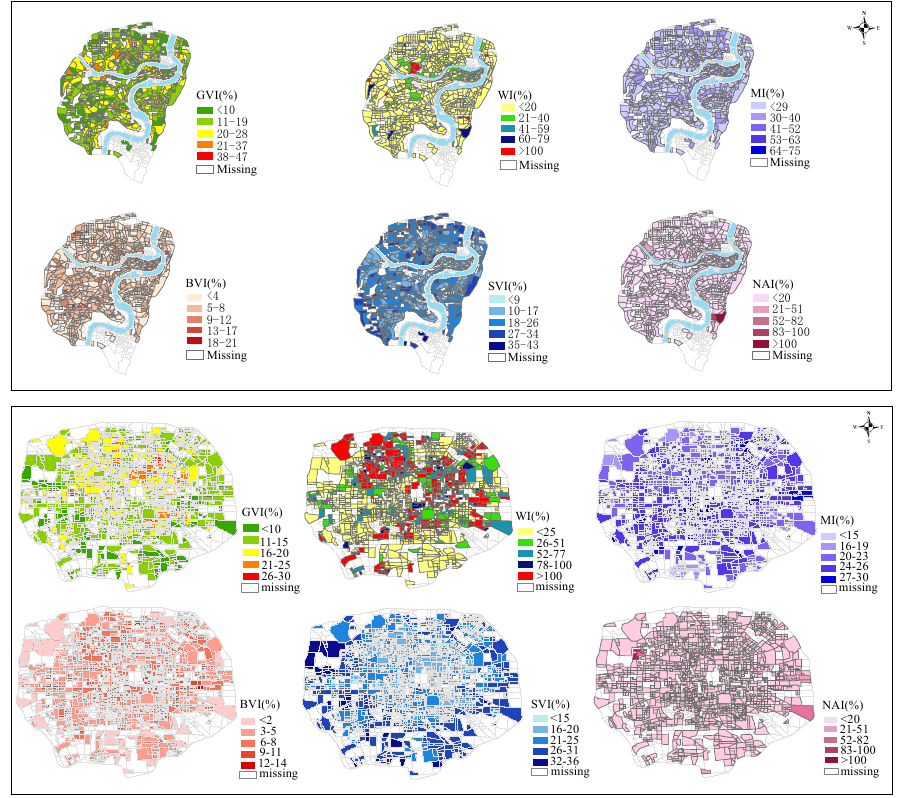
Figure 4. Distribution of quantitative results of six visual indices in Beijing and